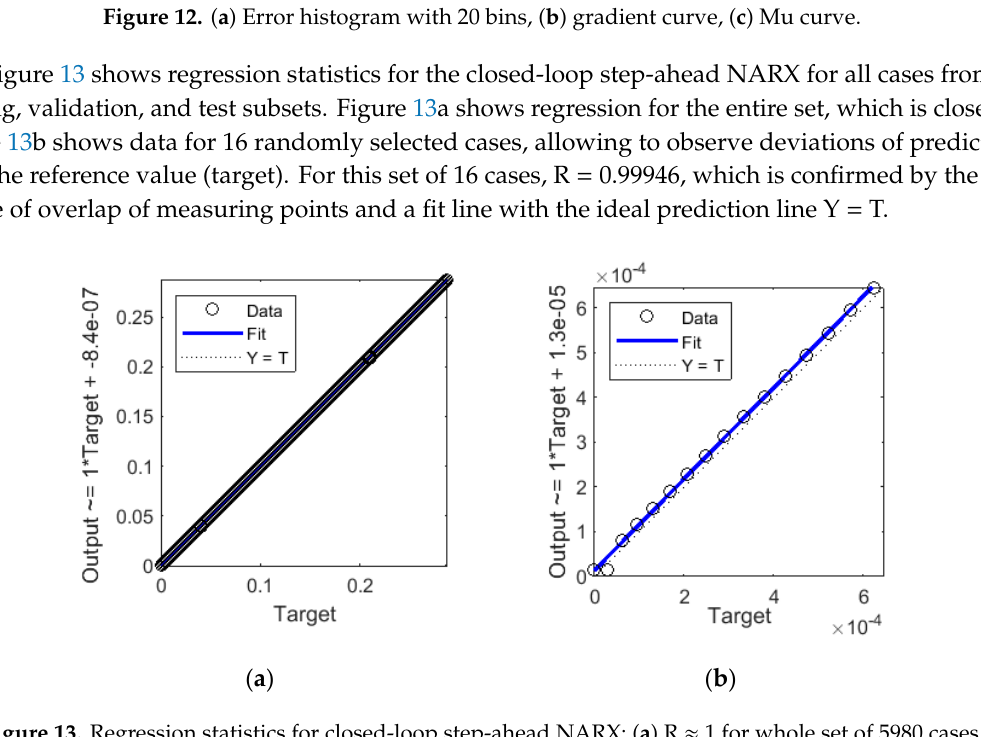
Table 3. Closed-loop NARX training results.